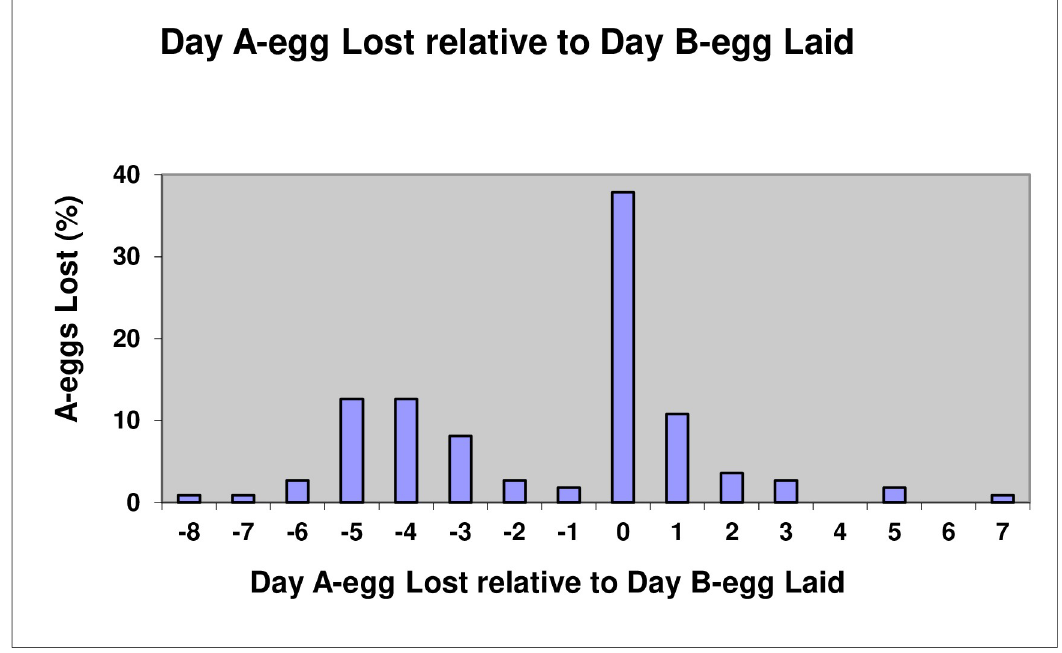
Fig 3. The day A-eggs were lost relative to the day of laying of the B-egg (n = 111). https://doi.org/10.1371/journal.pone.0275106.g003 Correlations of the age at which the A-egg was lost with body mass of the female and the dates of laying the A- and B-eggs are presented in Fig 5. Body mass of the penguins did not affect either the timing of breeding or the age at which the A-egg was lost. As might be